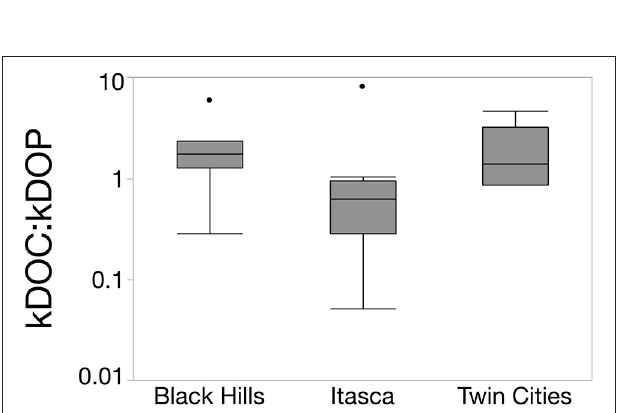
FIGURE 5 | Box and whisker plots showing the relative lability of DOC and DOP in the three regions studied. Relative %BDOP was higher than relative %BDOC in all three regions (pairwise t -tests, p < 0.01). Relative % BDOP also showed a much larger range of values compared to relative